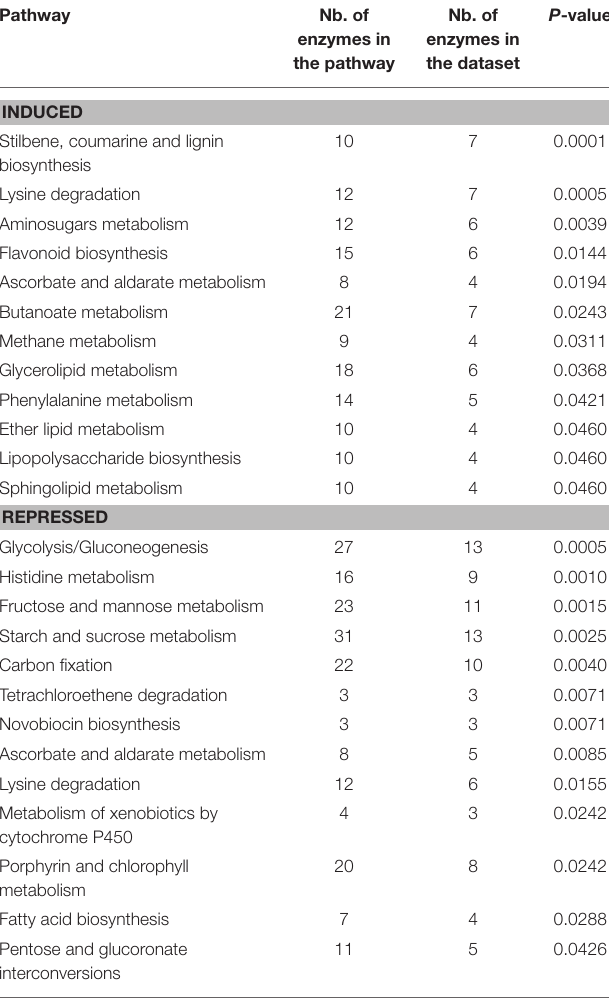
TABLE 2 | Pathexpress analysis of over-represented pathways among the gene probesets that were commonly induced or repressed by drought or active PR treatments in the Ljgln2-2